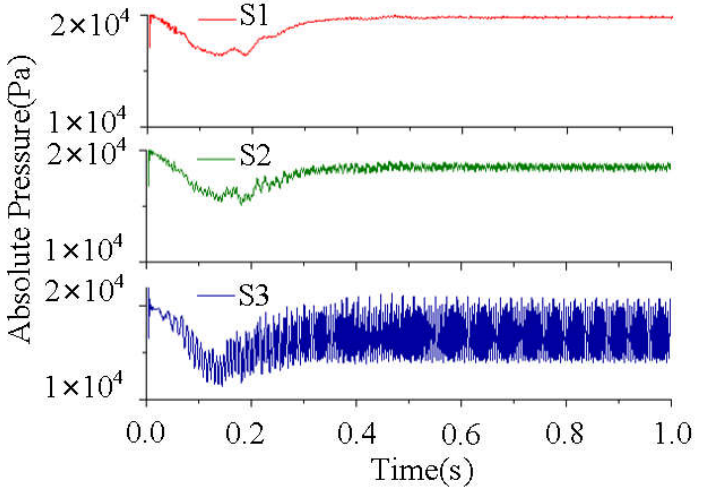
Figure 18. Development of pressure at the inlet guide vane.